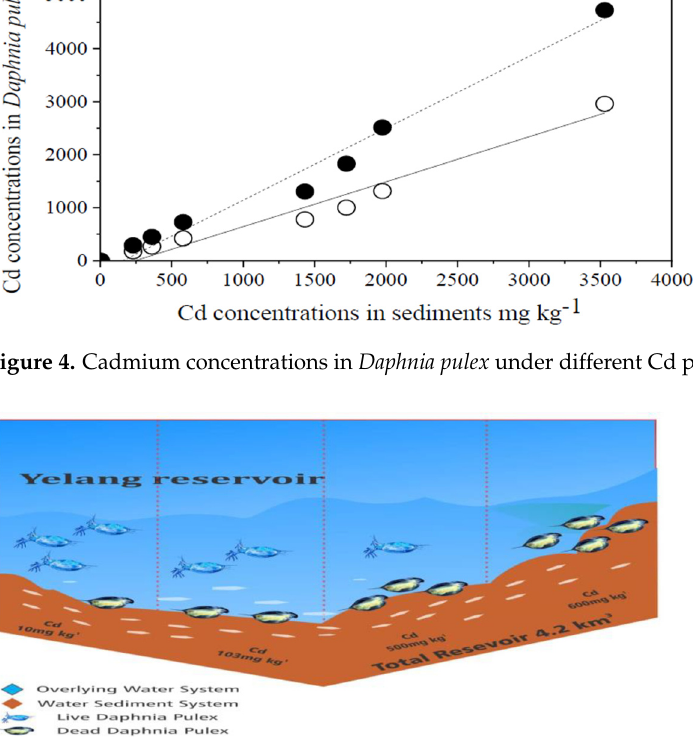
Table 7. Concentration and evaluation results of Cd in sediments at the Yelang reservoir.